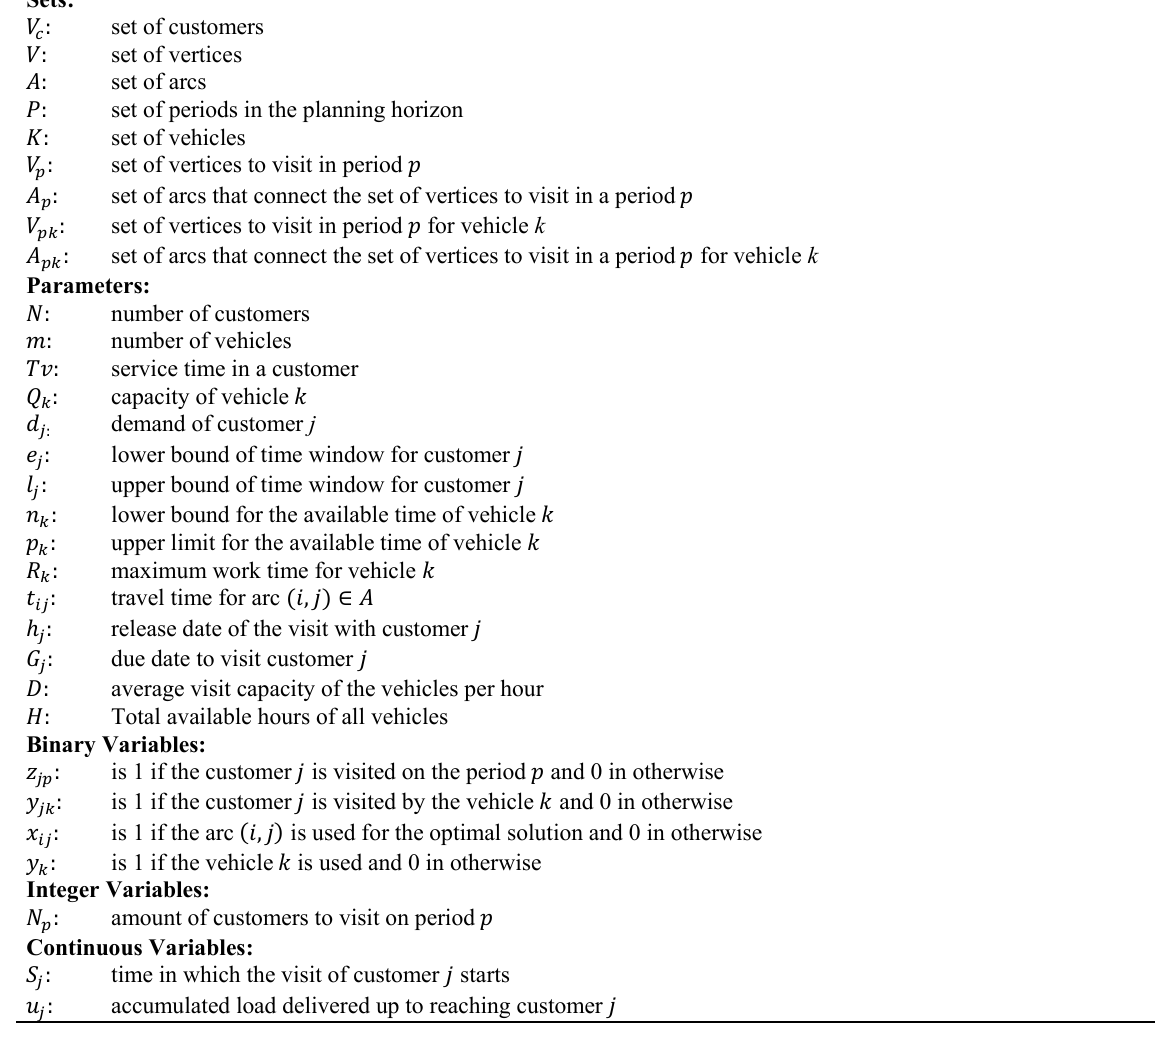
Notation used for scheduling, clustering and routing